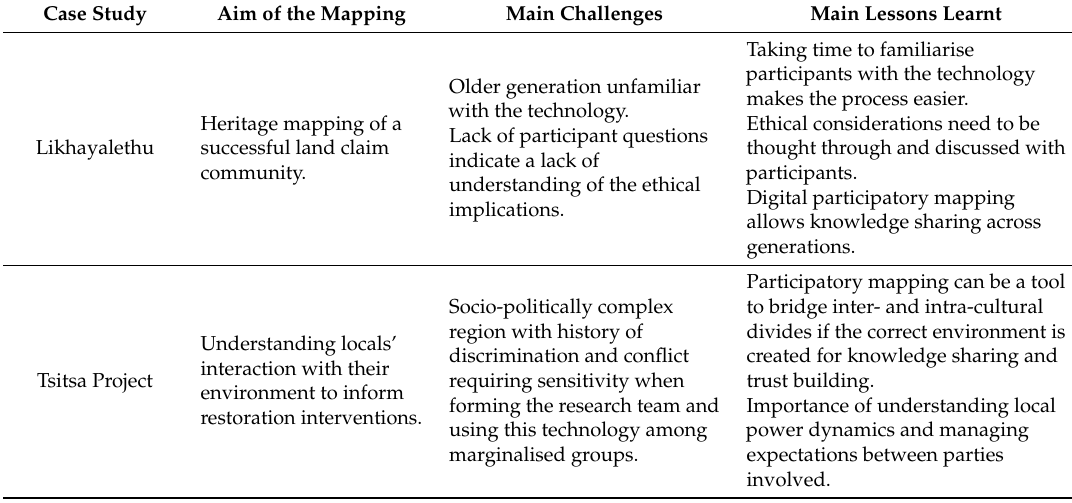
Table 1. Case study